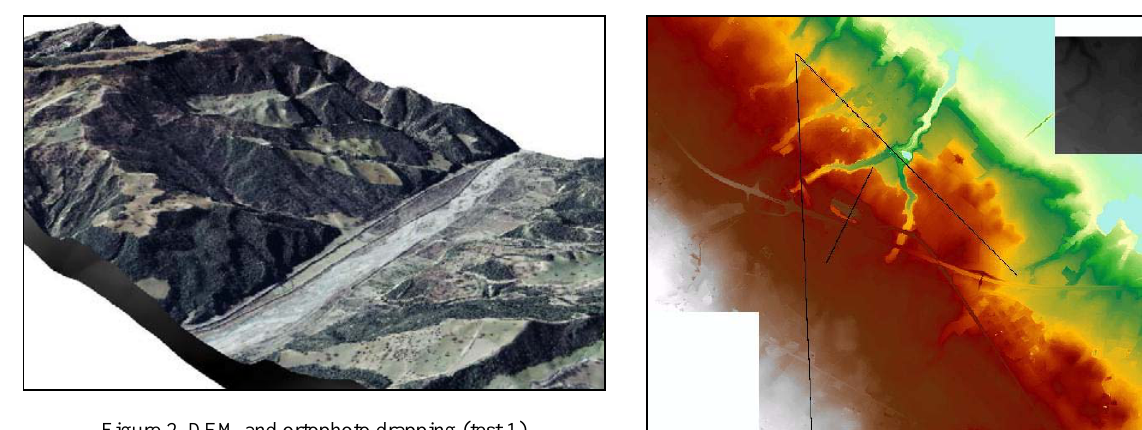
Figure 2. DEM and ortophoto drapping (test 1)